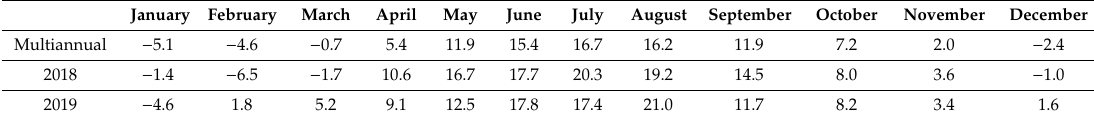
Table 2. Average monthly temperature ( ◦ C) in 2018 and 2019 compared to multiannual (100-year average).